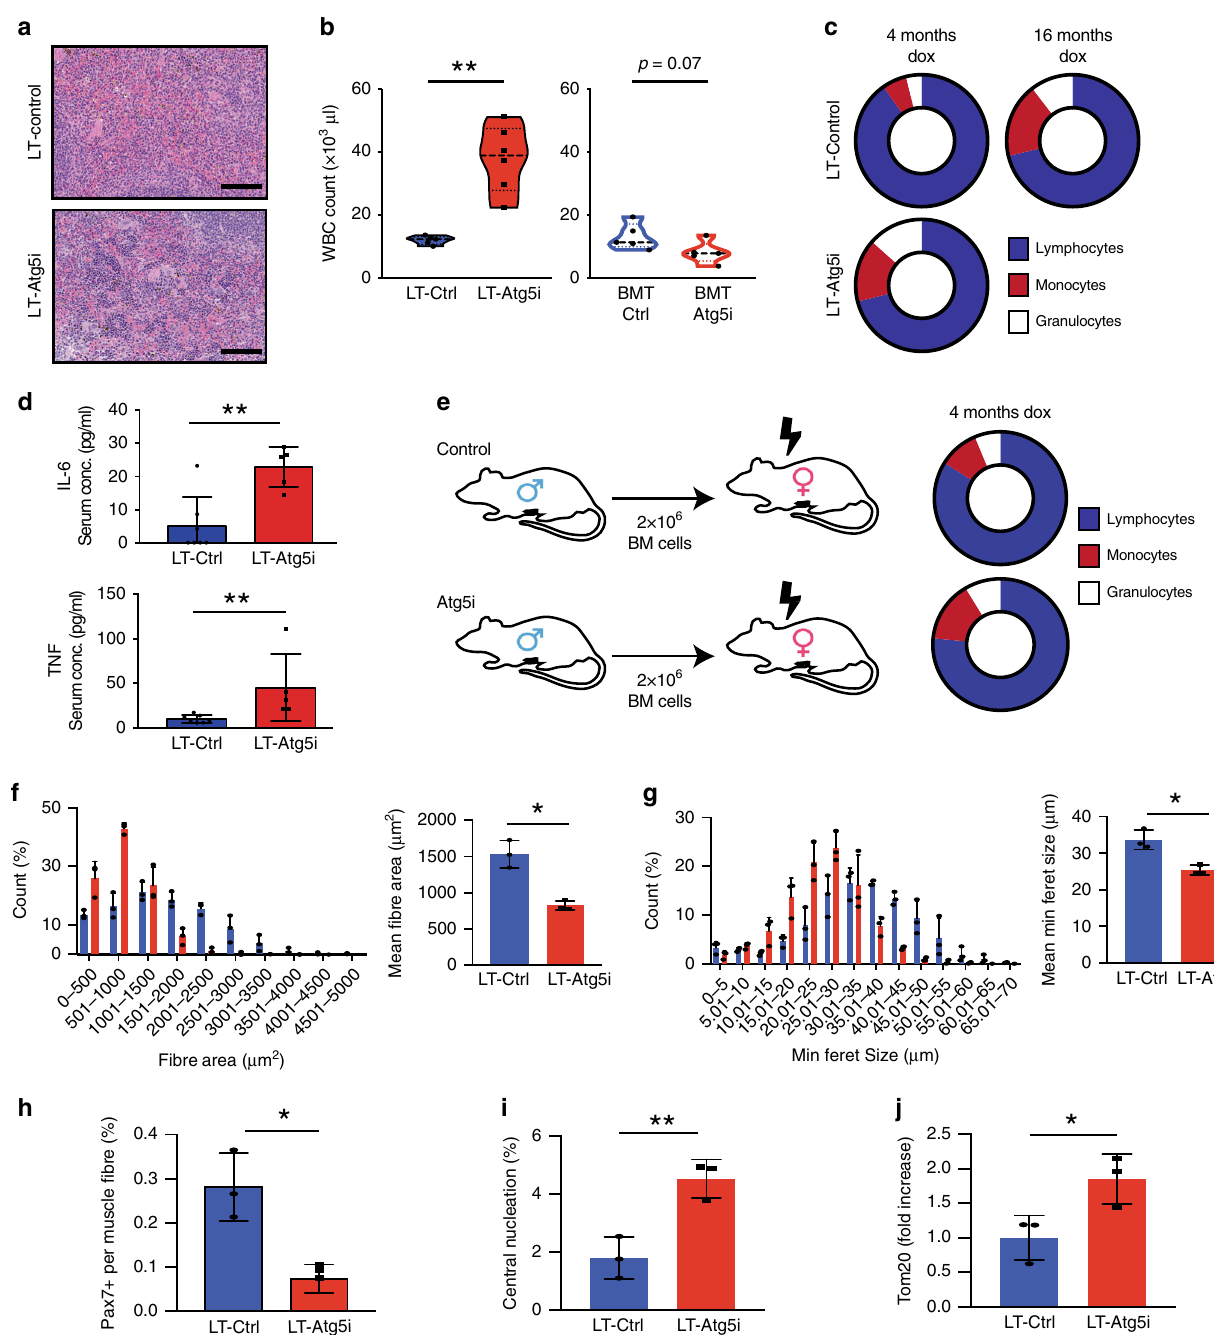
Fig. 2 LT-Atg5i mice present with accelerated aging phenotypes. a Extramedullary haematopoiesis is present in the spleens of LT-Atg5i mice in comparison with age-matched controls. Scale bars, 100 μ m. b 6-month-old LT-Atg5i mice (4 months dox treatment) display increased White Blood Cell counts (WBC). Meanwhile, irradiated wild-type mice in receipt of uninduced bone marrow from Ctrl or Atg5i mice display a reduced WBC count after 4 months of dox treatment (unpaired two-tailed Welches t test, n = 5 – 6 per group). c Composition of the peripheral immune system in LT-Atg5i mice is reminiscent of old control mice ( n = 5 – 6 mice per group). d 6-month-old LT-Atg5i mice (4 months dox treatment) displayed increased serum levels of IL-6 and TNF (LT-Atg5i n = 5, LT-Ctrl n = 7; Mann Whitney Test). e Bone marrow transplantation of uninduced Ctrl and Atg5i bone marrow into irradiated wild-type recipient mice after 4 months of dox treatment Atg5i recipient mice display a myeloid skewing. LT-Atg5i mice display alterations in skeletal muscle after 4-month of dox treatment. LT-Atg5i mice display a signi fi cant difference in cross-sectional area ( f ) ( n = 3 R-Ctrl and 3 R-Atg5i, unpaired two- tailed Welch ’ s t test) and minimum feret size ( g ) ( n = 3 R-Ctrl and 3 R-Atg5i, unpaired two-tailed Welch ’ s t test). LT-Atg5i mice also display a decrease